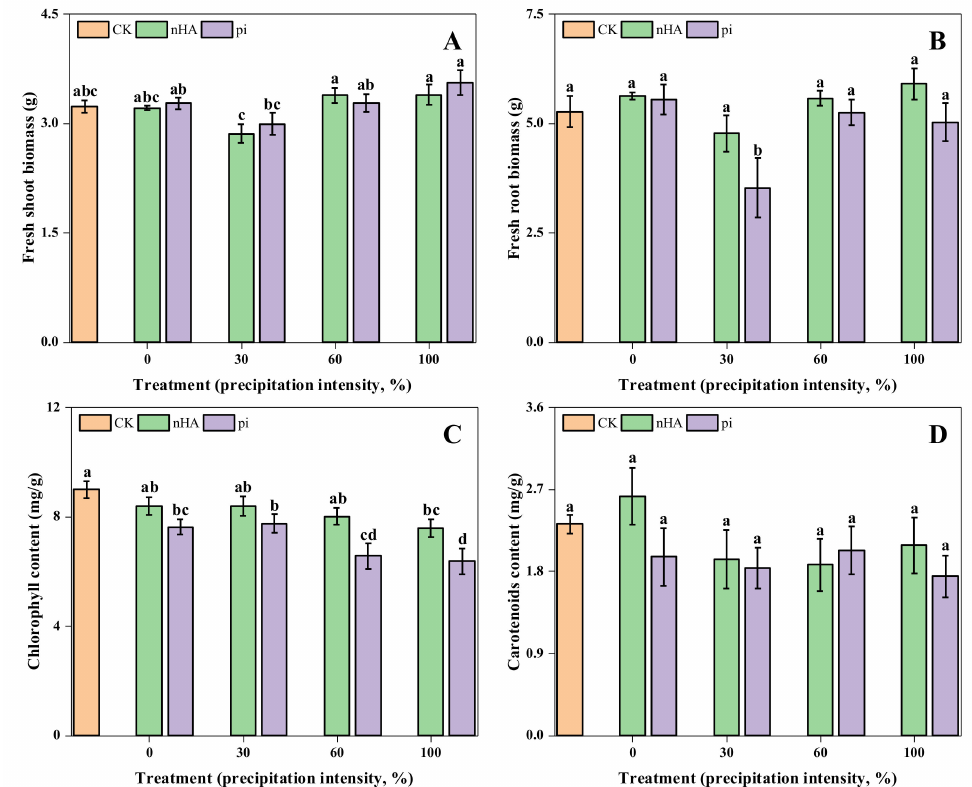
Figure 3. Physiological effects of foliar- and soil-applied nHA or pi on the growth of treated soybean (under a simulated precipitation scenario): ( A ) fresh shoot biomass, ( B ) fresh root biomass, ( C ) chlorophyll content, and ( D ) carotenoids content. Error bars correspond to standard errors of the means. Values of fresh biomass, chlorophyll, and carotenoid content that are followed by different letters are significantly different at p <